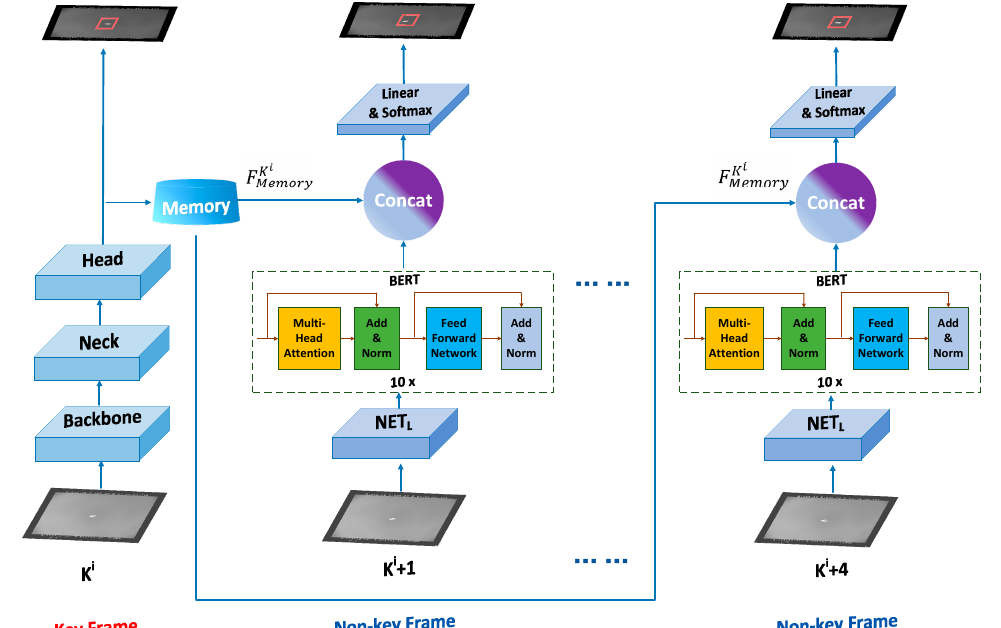
Figure 4. The overall framework of MSFE.